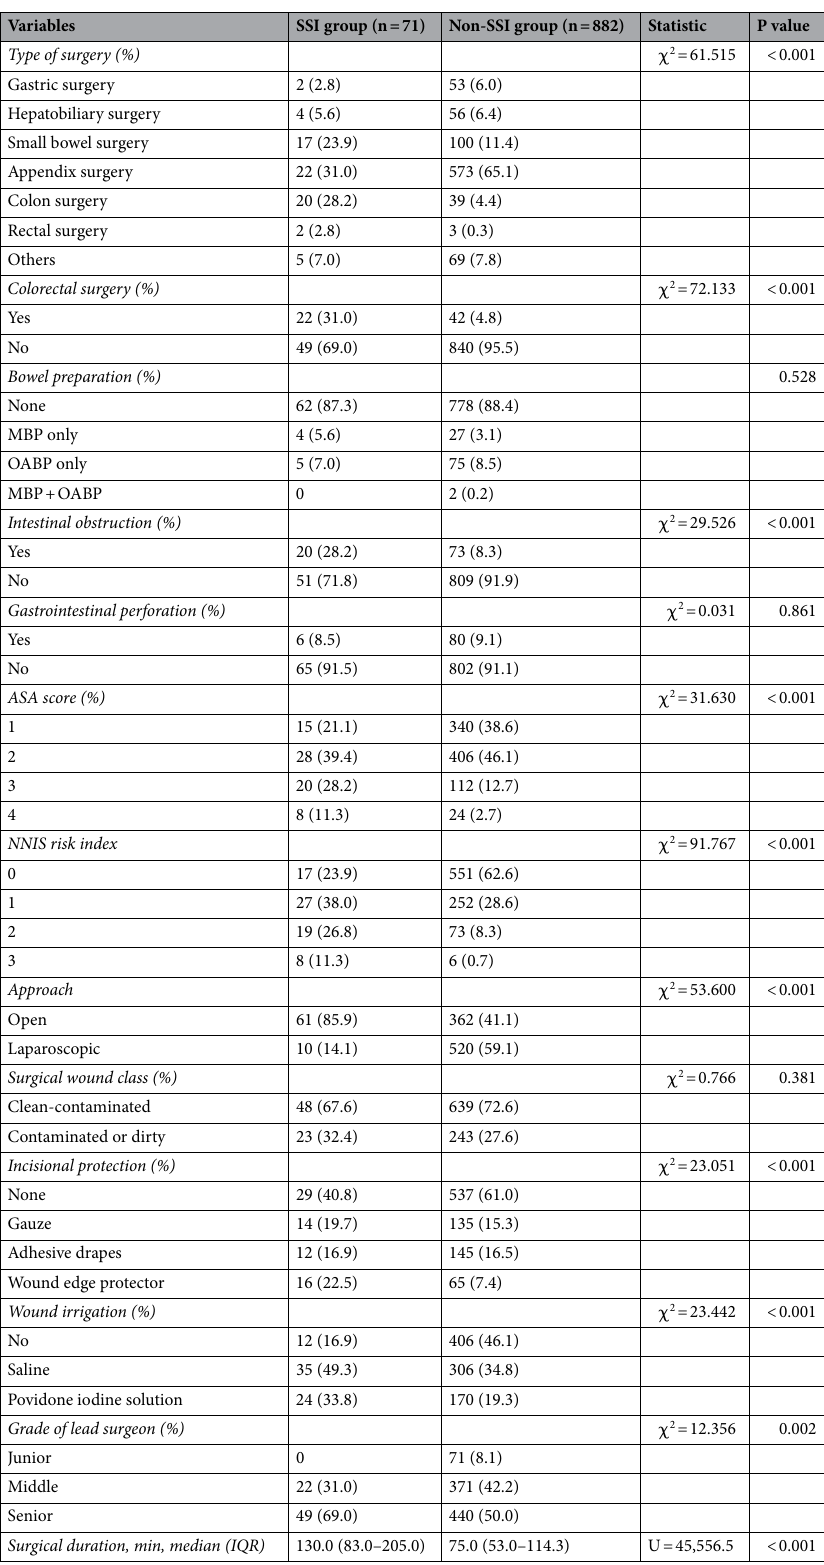
Table 3. Perioperative characteristics of included